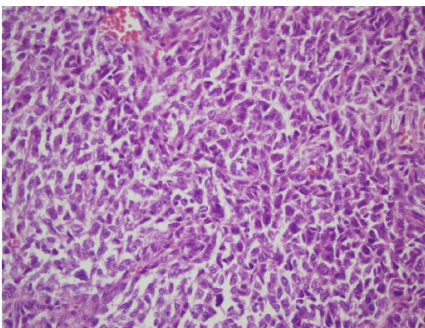
Figure 2: Round-fusiform shaped, diffuse neoplastic infiltration around the vascular structures with high magnification (H&E × 40).